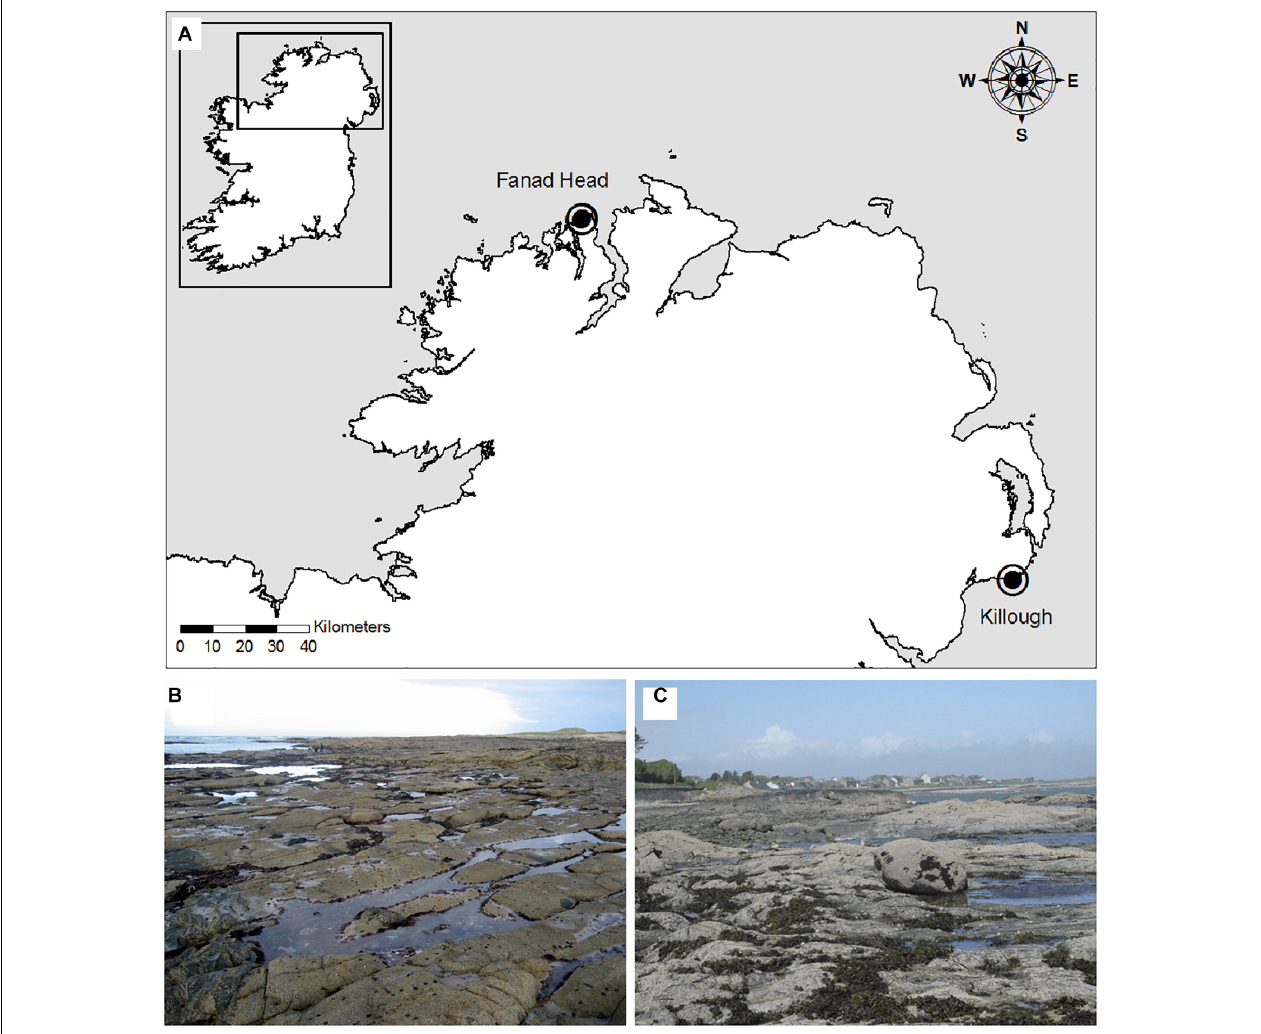
FIGURE 1 | (A) Experimental harvesting sites at Glashagh Bay, Fanad Head, Co., Donegal and Killough, Co., Down and shores where Corallina officinalis was harvested in pools at (B) Glashagh Bay and (C) Killough.